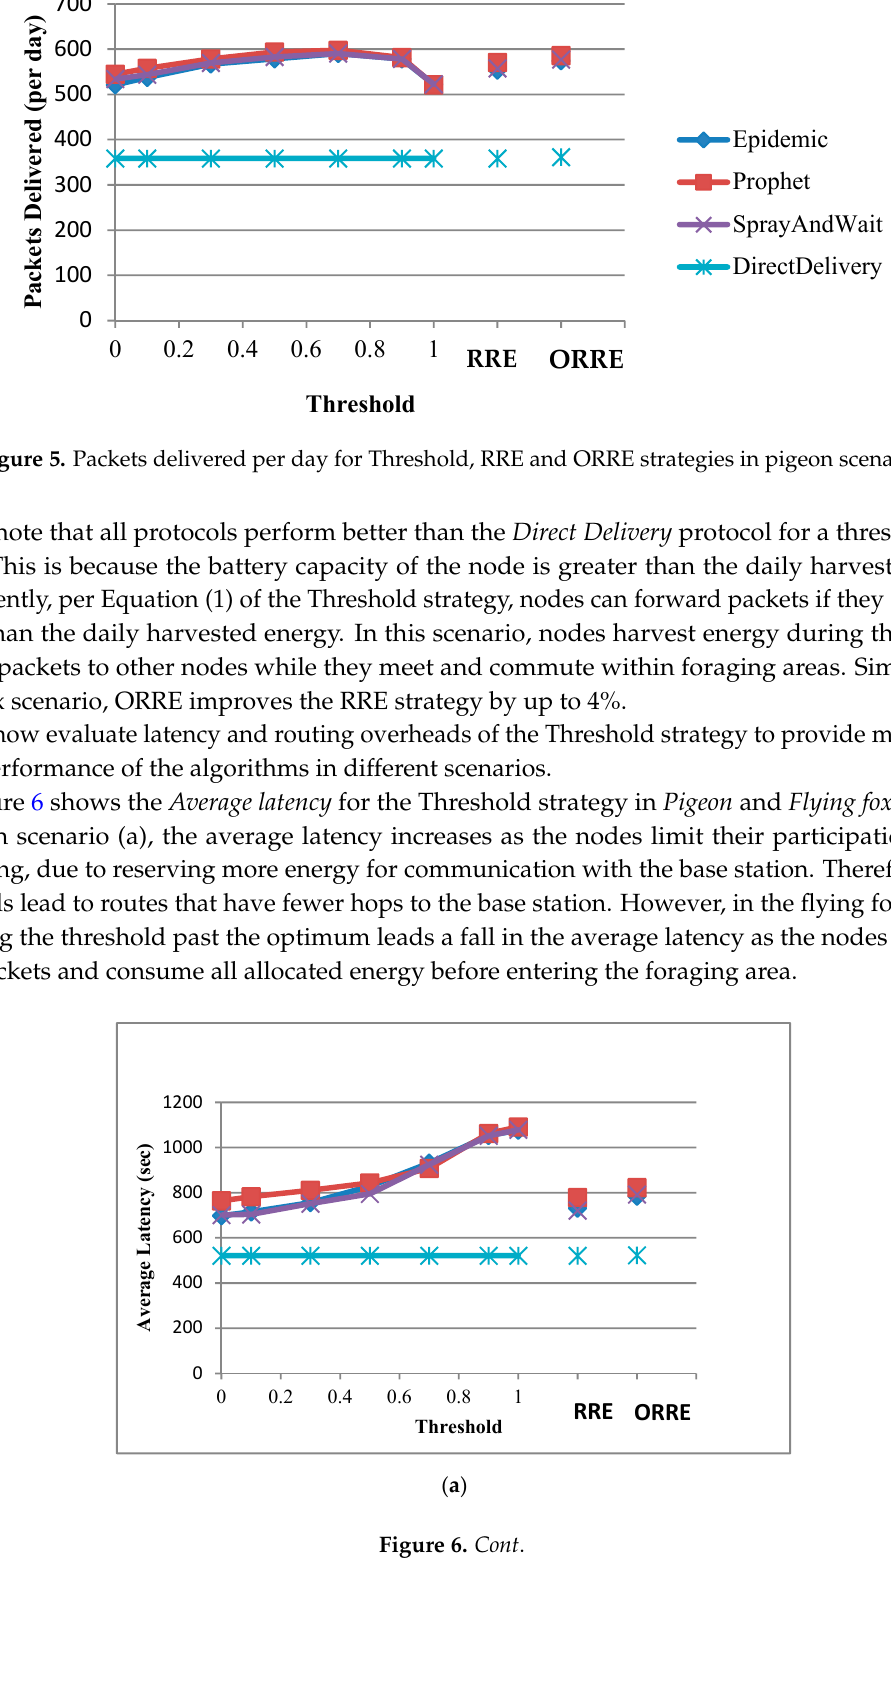
( b ) Figure 6. Average latency for Threshold, RRE, ORRE for ( a ) pigeon and ( b ) flying fox scenarios. ( a )